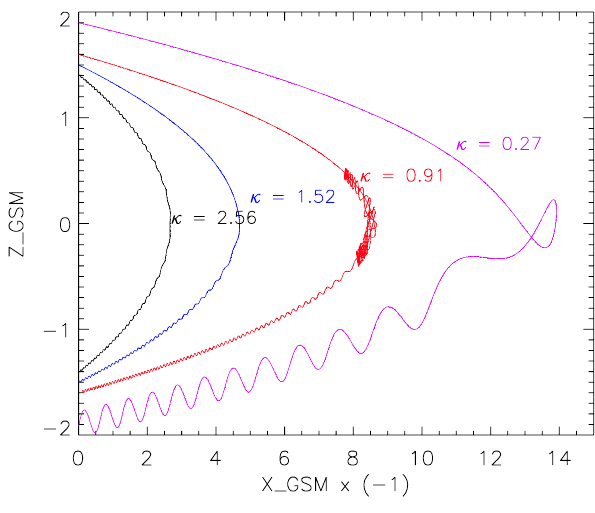
Fig. 4. Electron trajectories for field lines having four different κ , 2.56 (black), 1.52 (blue), 0.91 (red) and 0.27